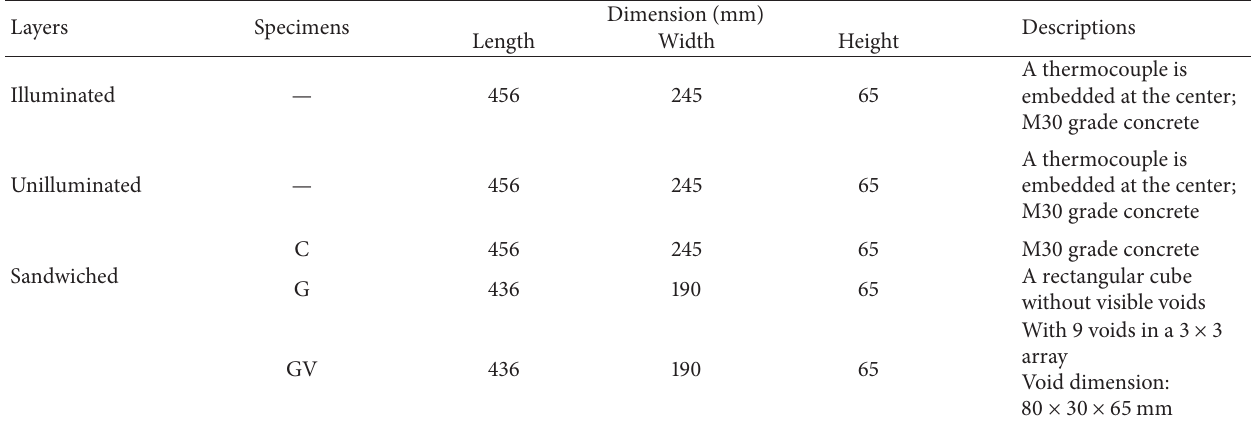
Figure 3: (a) Two concrete layers used as the illuminated and unilluminated layers with a thermocouple embedded in each of them; (b) a schematic diagram showing the specimen and the heat source; (c) the experimental setup. Table 1: Details of the layers used in the